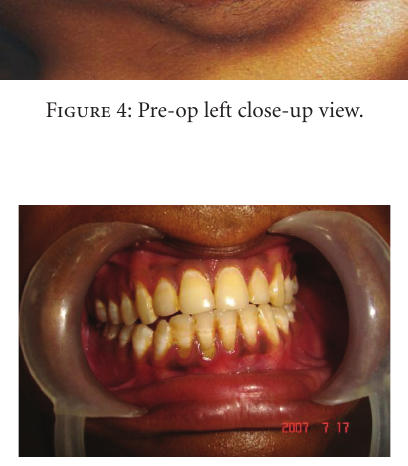
Figure 5: Pre-op occlusion.